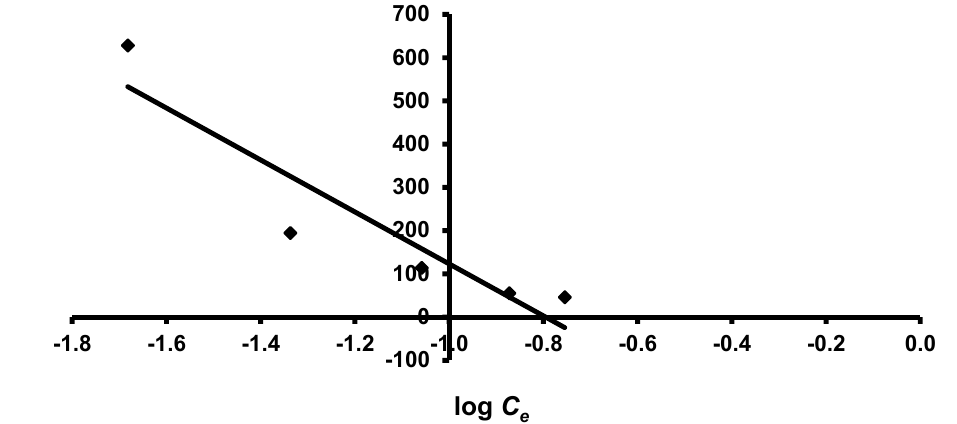
Figure 15. Linear Harkins–Jura isotherm of the removal of IV2R.